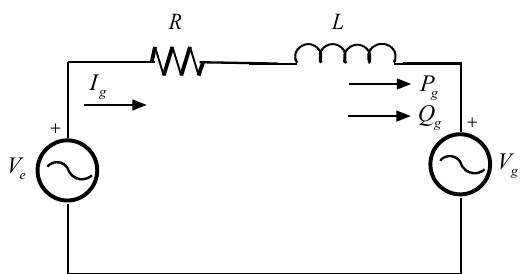
Figure 3. Equivalent circuit of the grid side converter, the connection system and the main network.